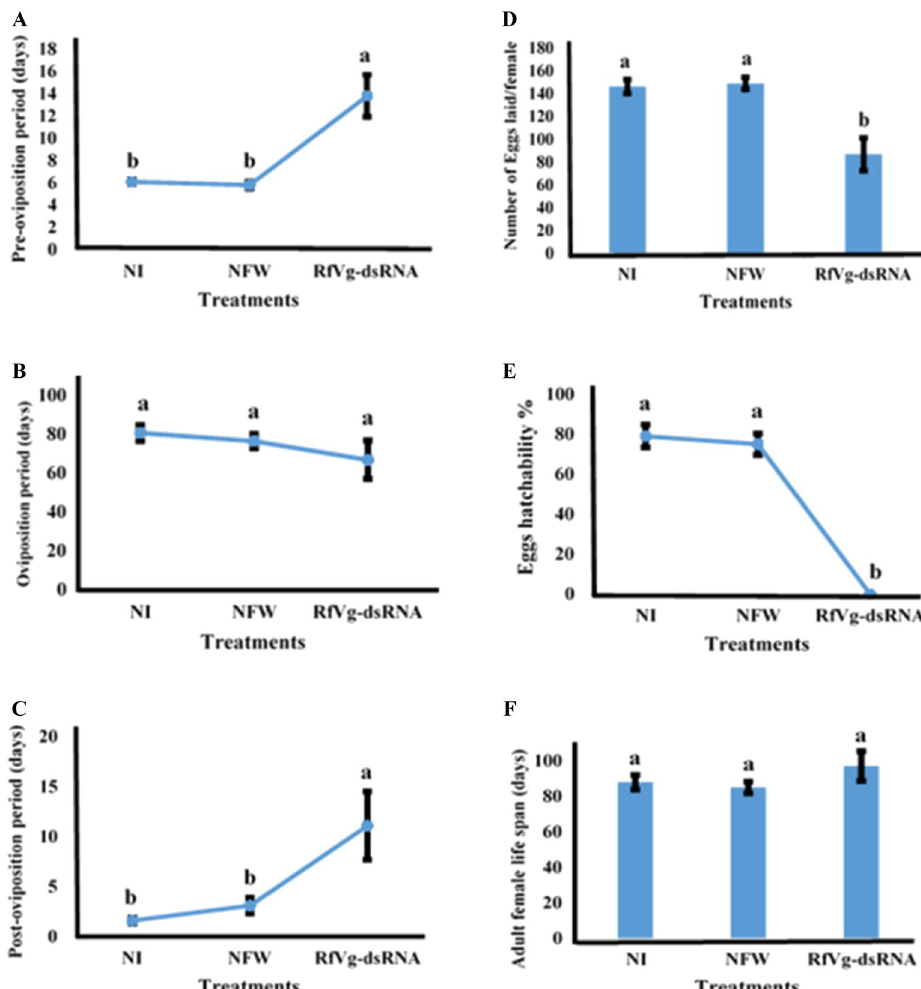
Figure 5. Effects of RfVg RNAi on reproductive traits of adult females of Rhynchophorus ferrugineus , pre- oviposition (A) , oviposition (B) , post-oviposition periods (C) , mean number of eggs laid per female (D) . Effects of RfVg -dsRNA injection on eggs hatchability % (E) . Effects of RfVg -dsRNA injection on adult female life span (F) . To test the statistical significance among different biological parameters, one-way analysis of variance was performed at (α = 0.05). Different letters above the bars show significant difference among